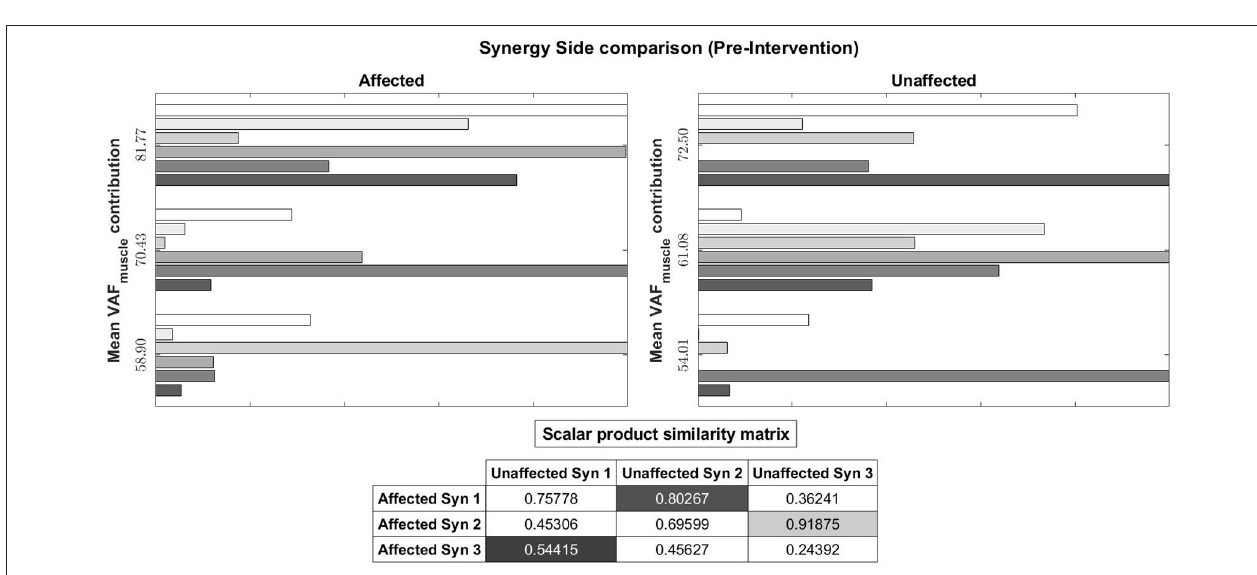
FIGURE 10 | Muscle synergy vectors of Subject 2, Pre intervention, Full Gait cycle. VAF to original states the contribution of each synergy to the original EMG. A higher value indicates a higher contribution. The scalar product similarity matrix shows results of comparing each synergy vector on the Affected side with all synergy vectors on the Unaffected side. Muscle synergies with the highest score are selected, matched and removed from the pool of muscle synergies. This process continues until no more muscle synergies are left to match. The synergies are matched in the sequence given by the color codes: 1st, Light gray; 2nd, Dark gray; 3rd, Black. The 1st synergy on the affected side is matched with the 2nd synergy on the unaffected side. Similarly, the 3rd synergy on the affected side is matched with the 1st synergy on the unaffected.